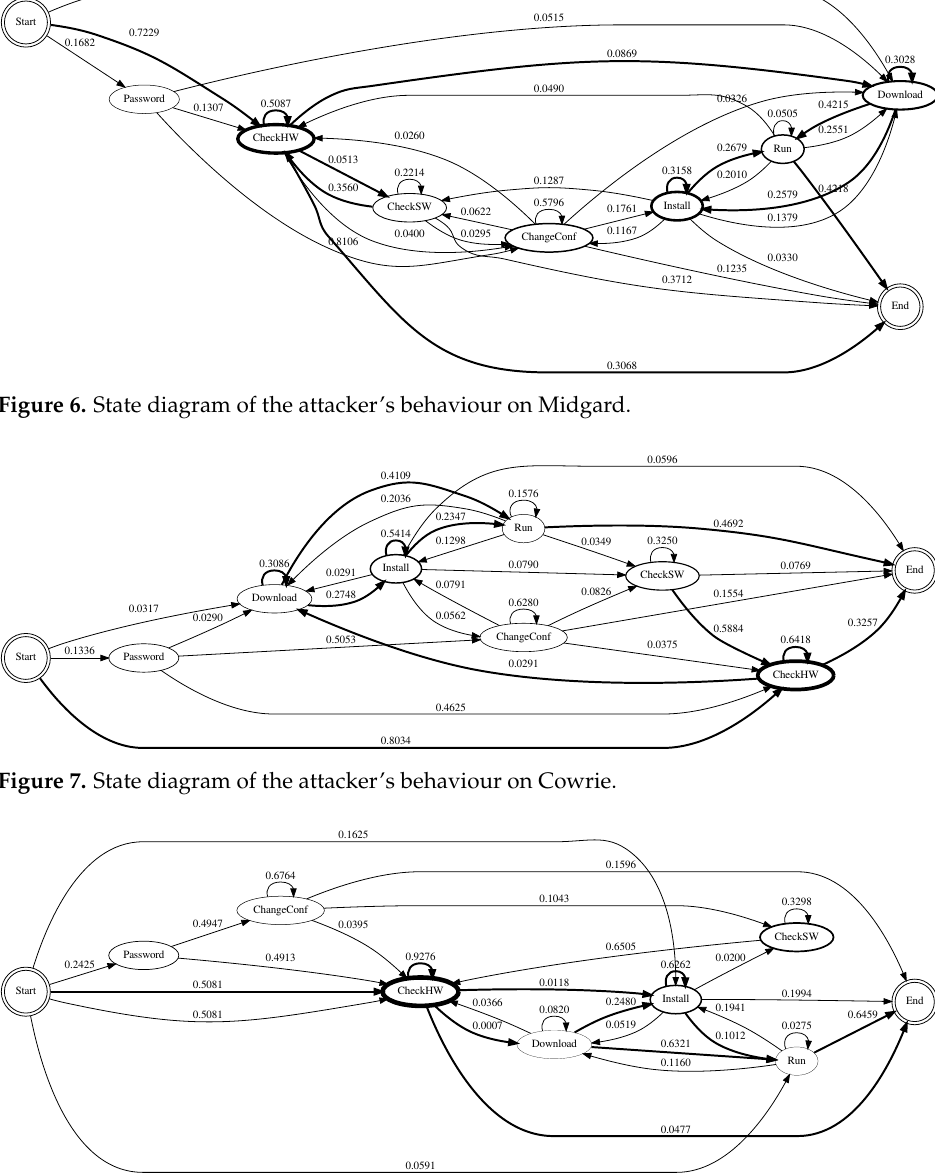
Figure 8. State diagram of the attacker’s behaviour on